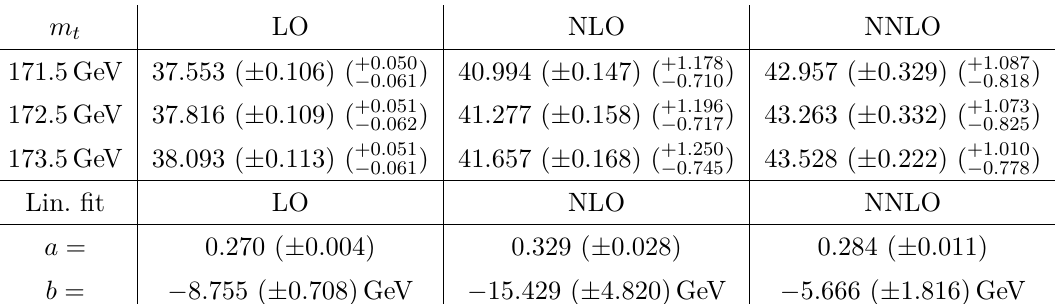
Table 2 . Values of E max ( B ) for the absolute differential cross section with full top quark decay at LO, NLO and NNLO and for three different values of m . Positions are fit using eq. (3.9) and 5 GeV t bins. Also given are the parameters of the linear fit eq. (3.7) at LO, NLO and NNLO.